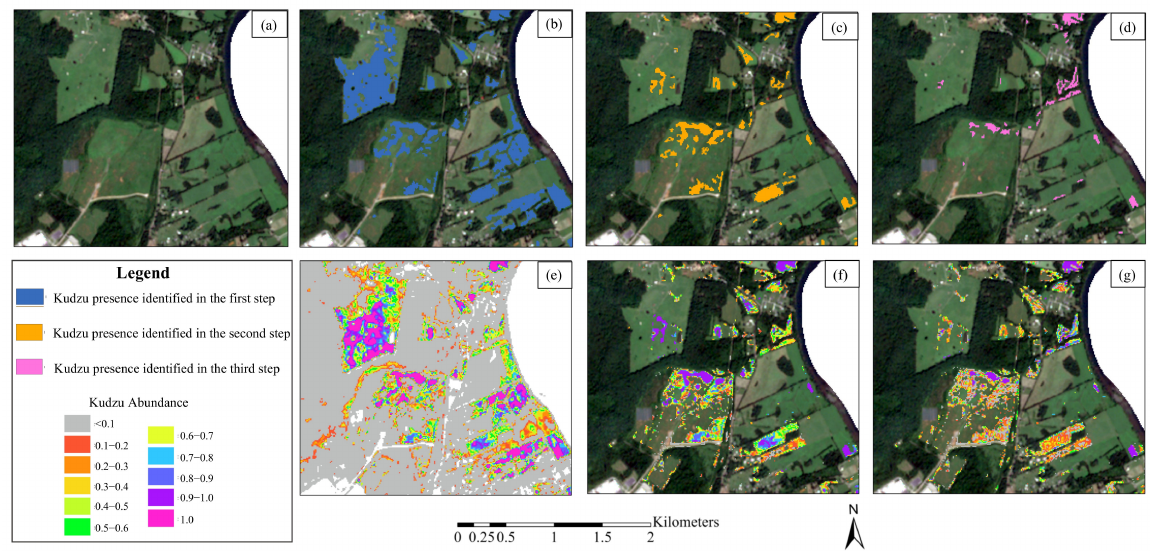
Figure 11. Misclassification of large grassland patches over the three steps: ( a ) true color composite image; ( b – d ) kudzu presence identified from steps 1 to 3, respectively; ( e – g ) kudzu abundance identified from steps 1 to 3, respectively.